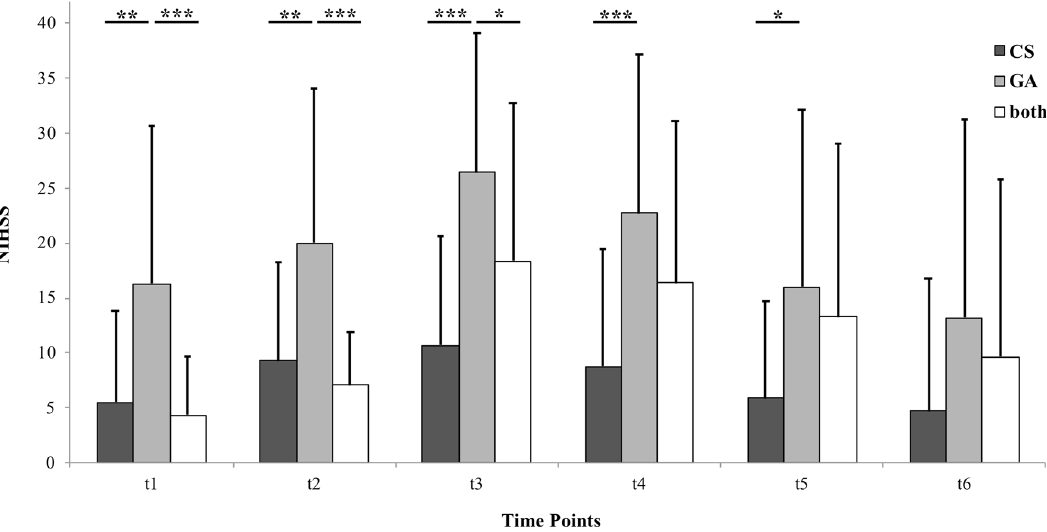
Figure2.BargraphdepictingNationalInstitutesofHealthStrokeScale(NIHSS)scoresofthethreeanesthesia groups. Patients were treated in conscious sedation ( “ CS ” ), general anesthesia ( “ GA ” ) or a combination of both ( “ both ” ). Each bar represents a different group. Each cluster represents a different time point. Time points are 24 hours before (first) intra-arterial vasodilator intervention (t 1 ), immediately before (t 2 ), immediately after (t 3 ), 24 hours after (last) intervention (t 4 ), at discharge from the hospital (t 5 ) and at six-month follow up (t 6 ). Data are presentedasmean+1StandardDeviation(SD)aserrorbars.Significantinter-groupdifferencesarehighlightedwith asterisks. One asterisk represents p < 0.05, two asterisks represent p < 0.01 and three asterisks represent p < 0.001.